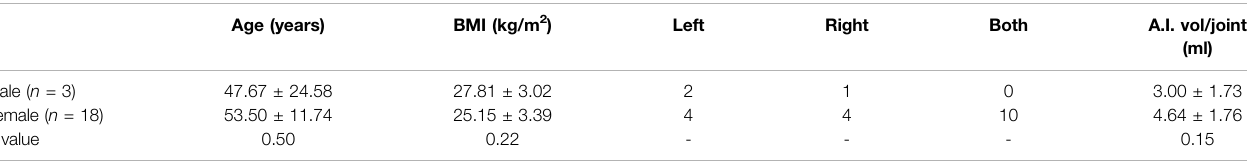
TABLE 2 | Clinical information of OA patients received ADSCs